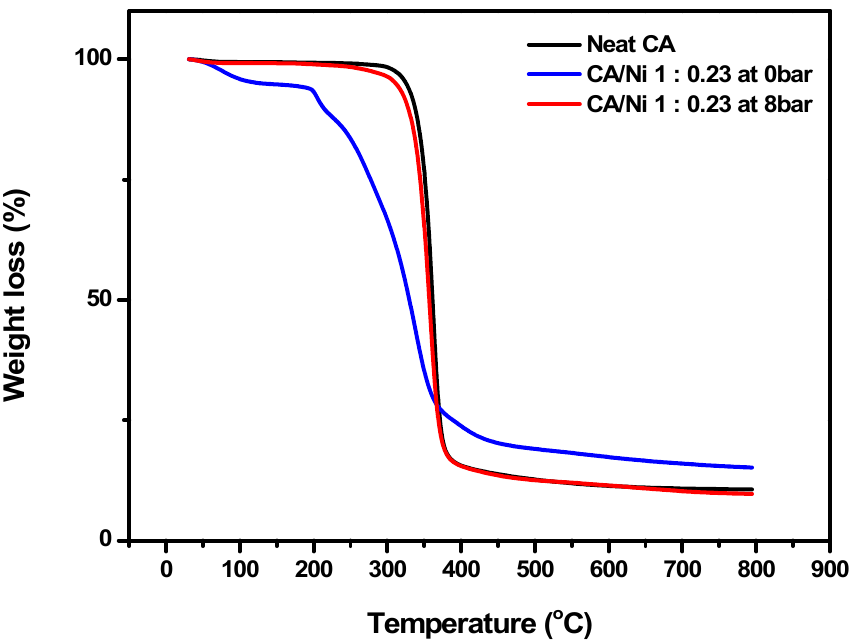
Figure 6. Thermogravimetric curves of neat CA, 1:0.23 CA / Ni(NO 3 ) 2 · 6H 2 O at 0 bar and 1:0.23 Figure 7. Thermogravimetric curves of neat CA, 1:0.23 CA/Ni(NO 3 ) 2 ·6H 2 O at 0 bar and 1:0.23 CA / Ni(NO 3 ) 2 · 6H 2 O at 8 CA/Ni(NO 3 ) 2 ·6H 2 O at 8 bar.